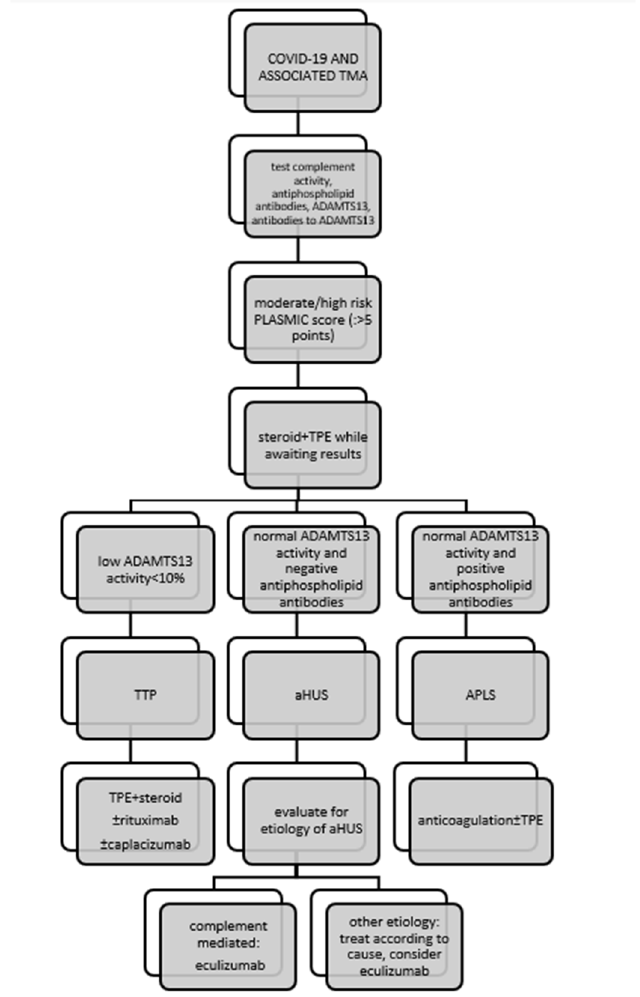
Figure 1. Management of patients with COVID-19-associated thrombotic microangiopathy. Legend: APLS, antiphospholipid syndrome; ADAMTS13, a disintegrin and metalloproteinase with a throm- bospondin type 1 motif, member 13; PLASMIC, platelet count, combined hemolysis variable,